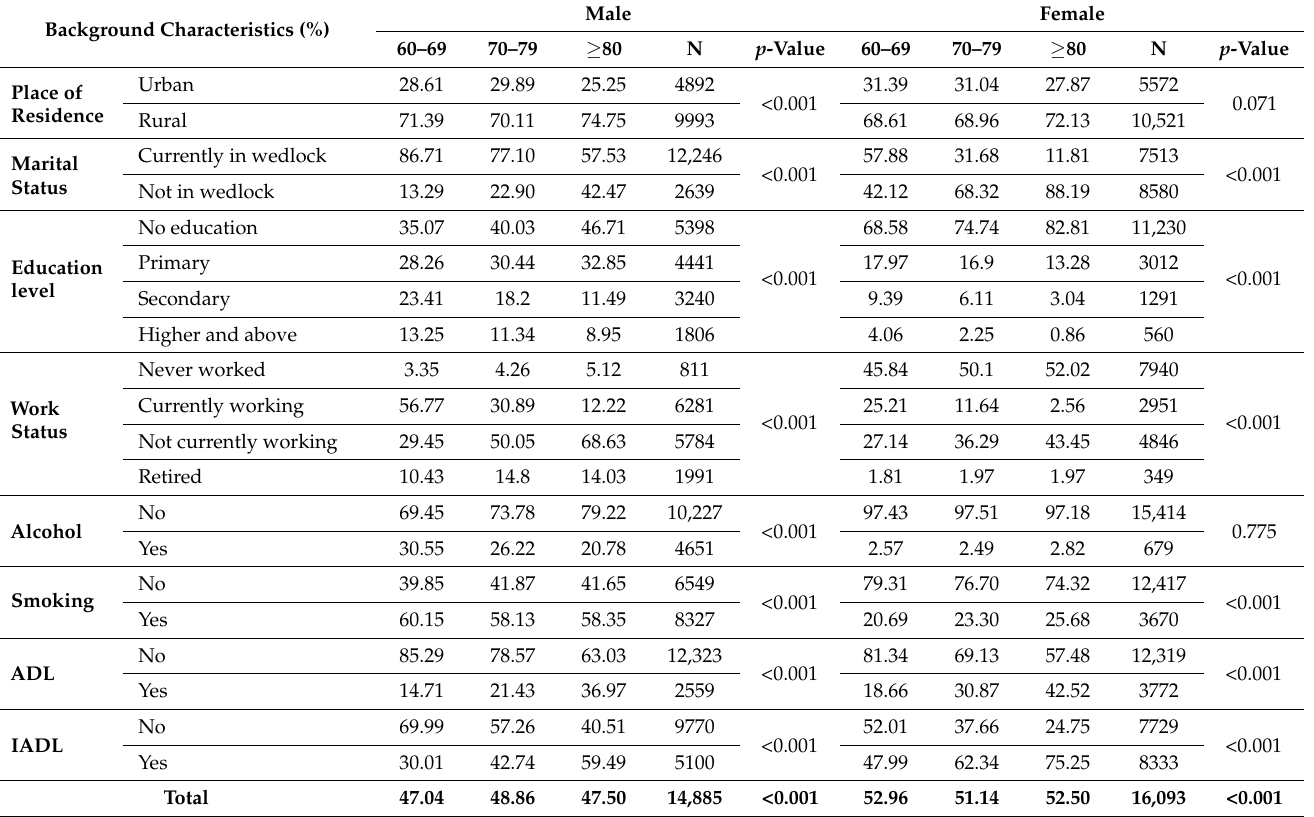
Table 1. Background characteristics of the study population (in percentage) in India,